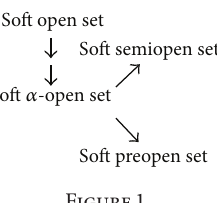
Proposition 11. (1) Arbitrary union of soft 𝛼 -open sets is a soft 𝛼 -open